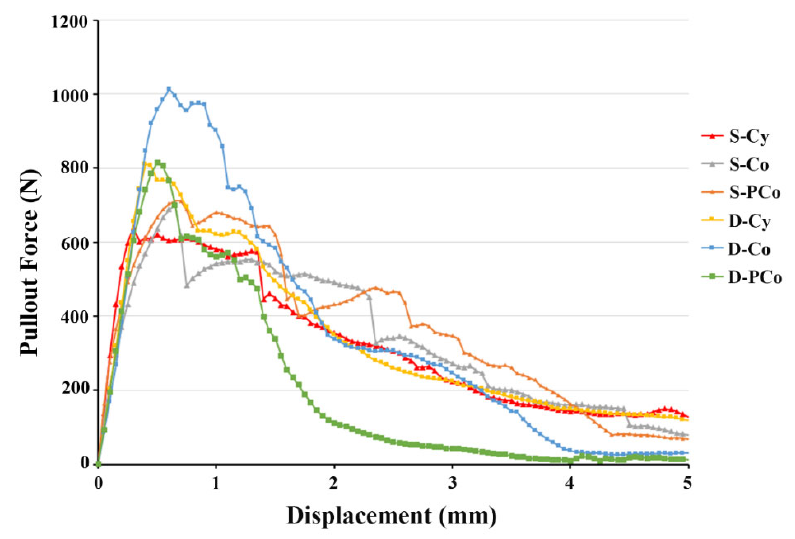
Figure 5. Typical force–displacement curve for screws of various geometries. Dual-thread screws had a higher pullout force than single-thread screws.